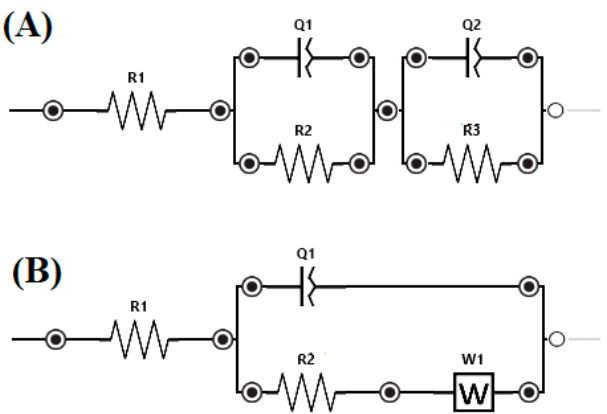
Figure 16. Equivalent electrical circuits for the bulk alloy samples: ( A ) For sample Ti 60 Zr 10 Si 15 Nb 15 and Table 6. Electrochemical impedance spectroscopy (EIS)